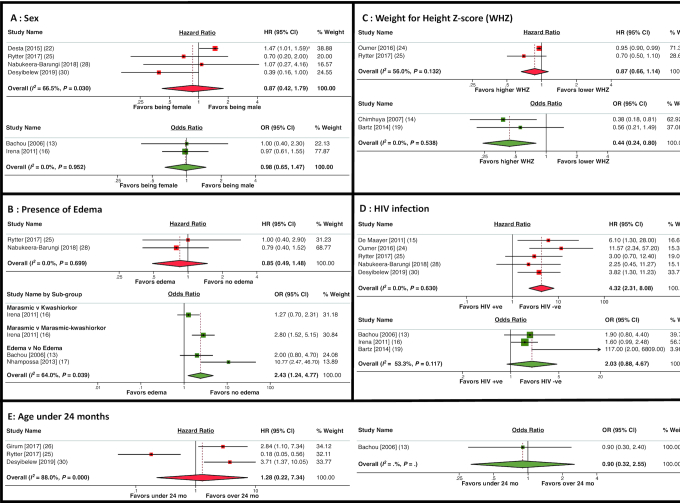
Forest plots of the meta-analysis of sex (A), presence of edema (B), WHZ (C), HIV infection (D), and age <2 y (E), on mortality in children admitted with SAM. Results with HRs are shown in red and studies reporting results in ORs are shown in green. aThis result was reported as aHR: 0.679 (95% CI: 0.63, 0.99) among males. However, given the CI presented, it is likely there is a typographical error and the point estimate should be 0.79. We contacted the authors but did not receive a reply. We have therefore used the value as published. We found no change in inference from using the likely alternative value. WHZ, weight-for-height z score.